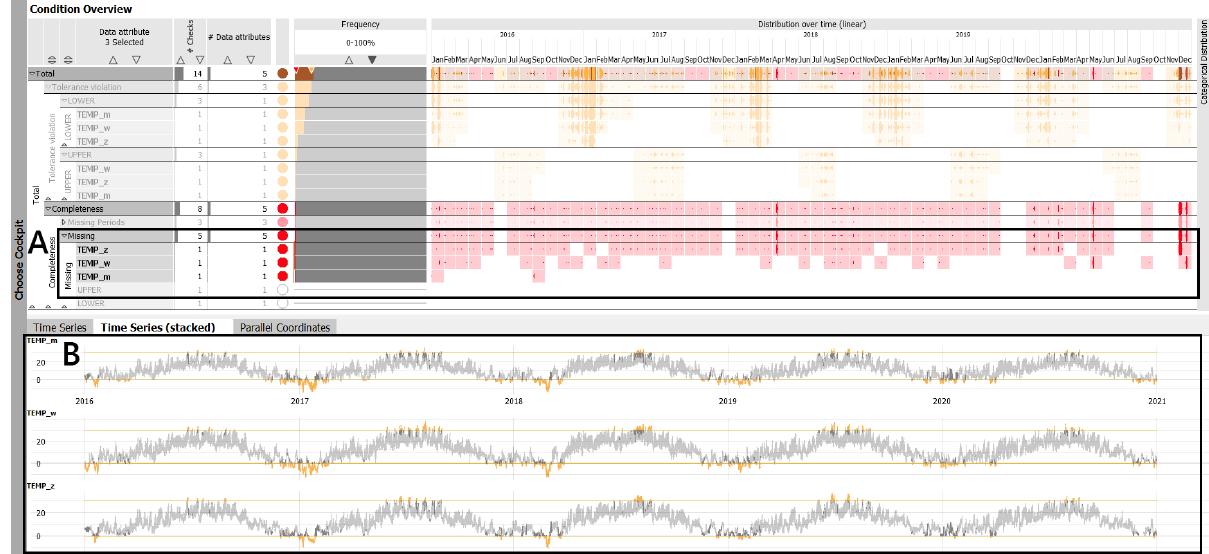
Figure 2. Illustration of a toolkit for data quality check available at the used VA tool: ( A ) the detected missing values in the whole data pool with exact positioning of concerned missing instances marked with red lines, ( B ) visual detection of threshold breaches for those instances when a value exceeds 30 °C or goes below 0 °C.